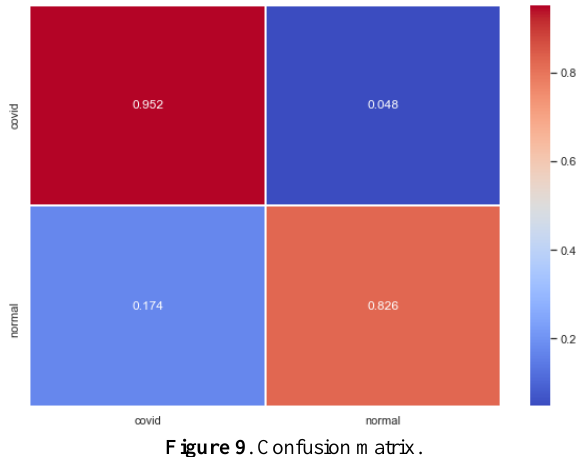
Figure 9 . Confusion matrix. From the plotted diagrams, we can conclude that the method and specifically the transfer learning mechanism it utilizes allows for fast differentiation of images belonging to patients from those belonging to healthy individuals. Using categorical cross entropy loss function and a batch size of 4 for classification, the outputs converged after 40 epochs, showing no significant change thereafter. network modified with transfer learning to rapidly differentiate healthy and COVID-19 instances at acceptable accuracy